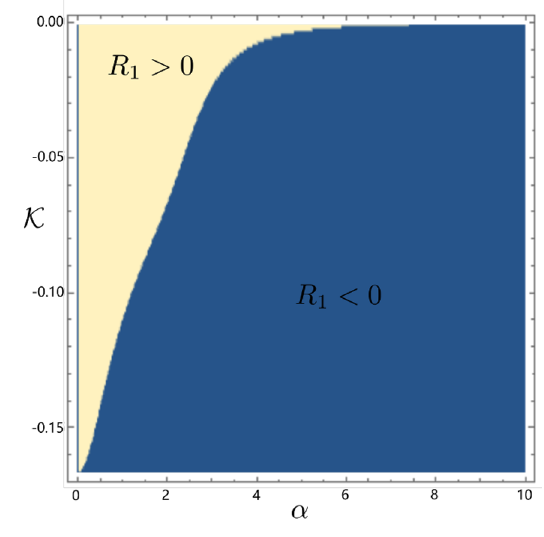
Figure 13 . Distribution of the sign of R 1 in (4.6) as a function of the disorder strength (cid:11) and the coupling constant K for the Linear model (3.23). We have set B = 0 and worked in units with (cid:26) =